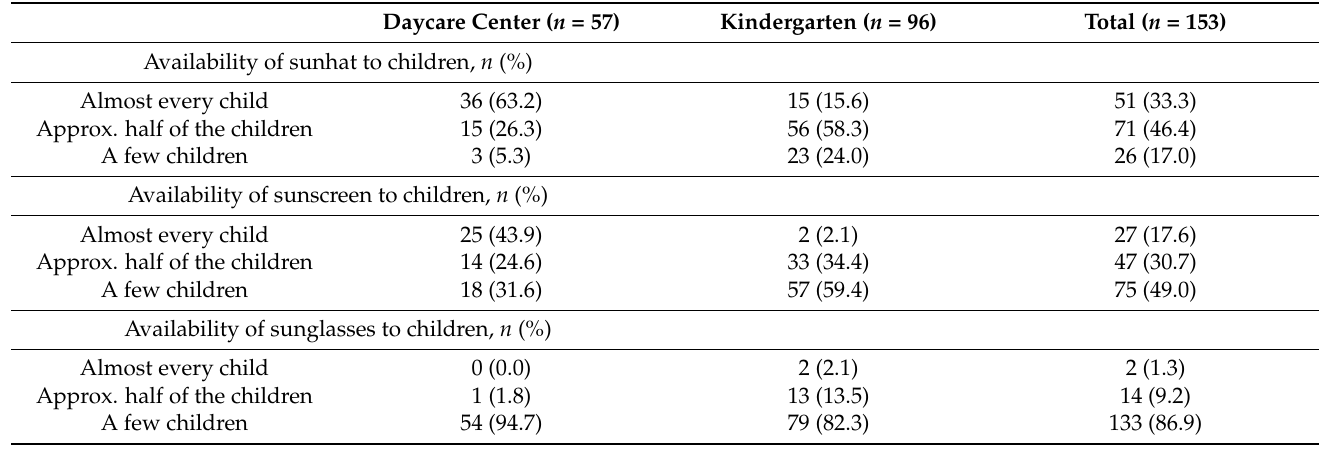
Table 2. Availability of sunscreen, sunhat, and sunglasses based on the judgment of caregivers.